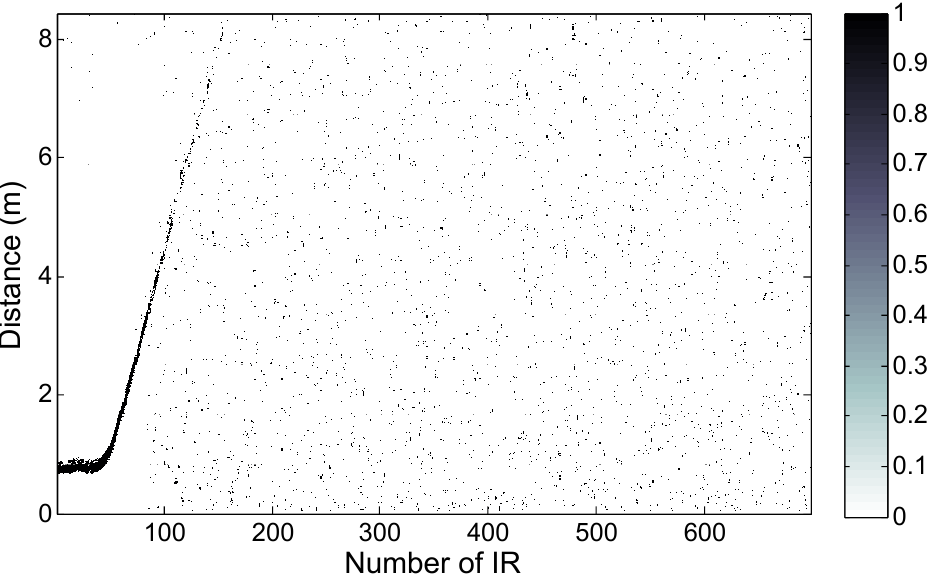
Figure 9. Detection of the moving person by 9th-order M-sequence multi-chip radar, maximum distance 41